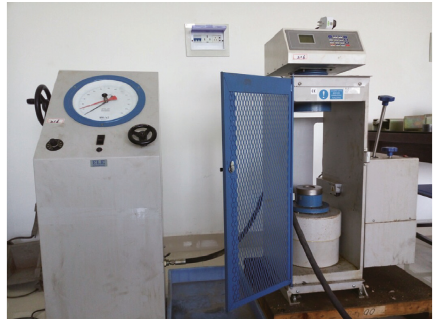
Figure 3: Testing equipment for triaxial compression.